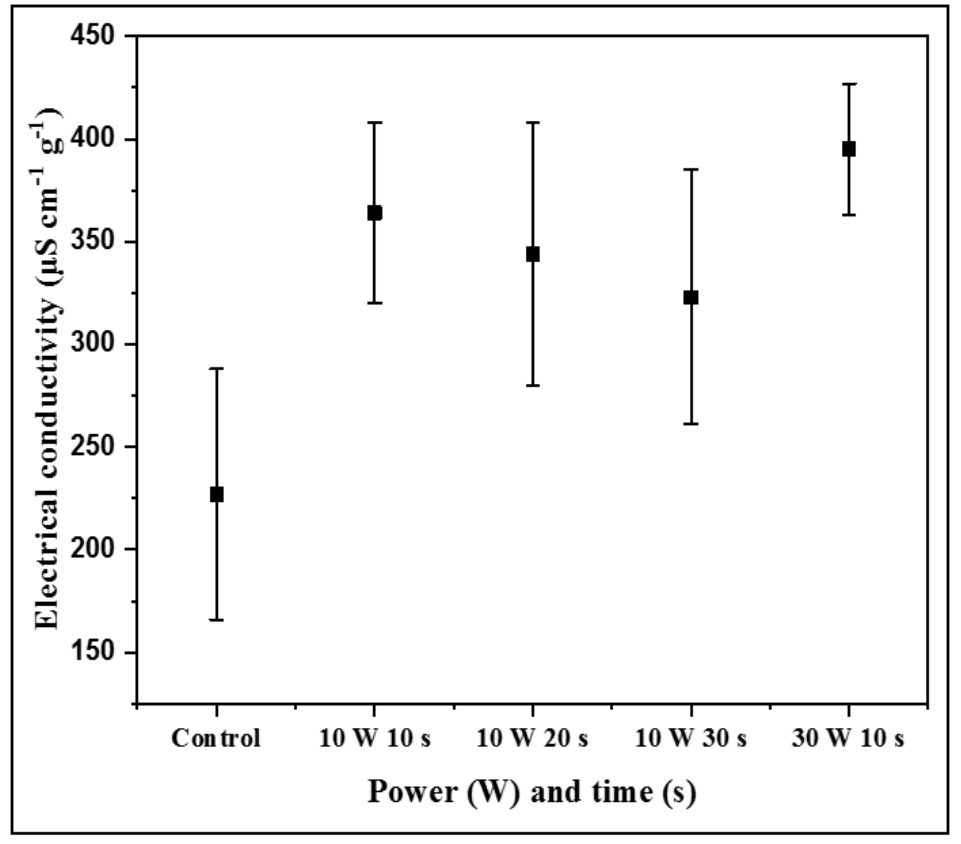
Figure 6. Electrical conductivity ( µ S cm − 1 g − 1 ) of solutions containing H 2 O-LPP-treated and untreated Bambara groundnut seeds. Experiments were performed in five replicates, n = 5 (20 seeds—i.e., ~ 5 g, were used in each replicate). Error bars refer to the standard deviations of the five replicates.